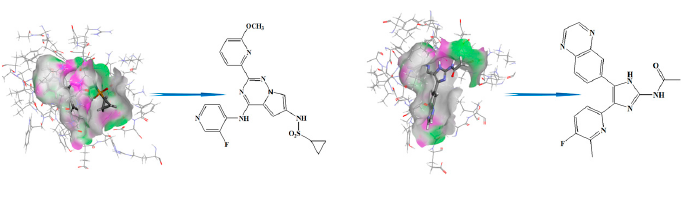
Figure 2. A set of 17 compounds made up the training set used in common feature pharmacophore Figure generation.